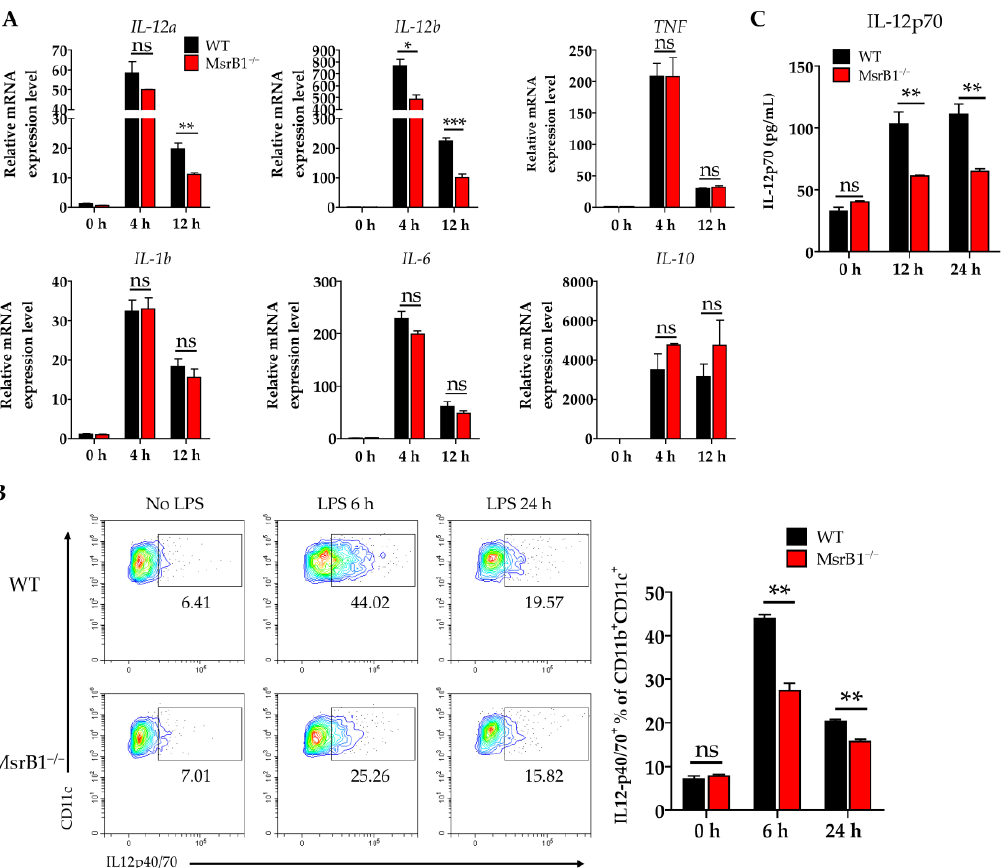
Figure 4. MsrB1 promotes the production of IL-12 by DCs in vitro. ( A ) WT and MsrB1 − / − BMDCs were stimulated with LPS for the indicated times ( n = 3 per group) and their transcript levels of IL-12a , IL-12b , TNF , IL-1b , IL-6 , and IL-10 were analyzed by qRT-PCR. ( B ) The intracellular IL-12p40 / 70 levels in WT and MsrB1 − / − BMDCs at the indicated time points after LPS stimulation ( n = 3 per group) were measured by flow cytometry with gating on the CD11c + CD11b + cells in the live cells. ( C ) The extracellular levels of IL-12p70 in the BMDC cultures were measured by ELISA ( n = 3 per group). Mean ± SEM are shown. * p < 0.05, ** p < 0.01, *** p < 0.001; ns, not significant, as determined by unpaired t- test. The data are representative of two experiments, which had similar results.